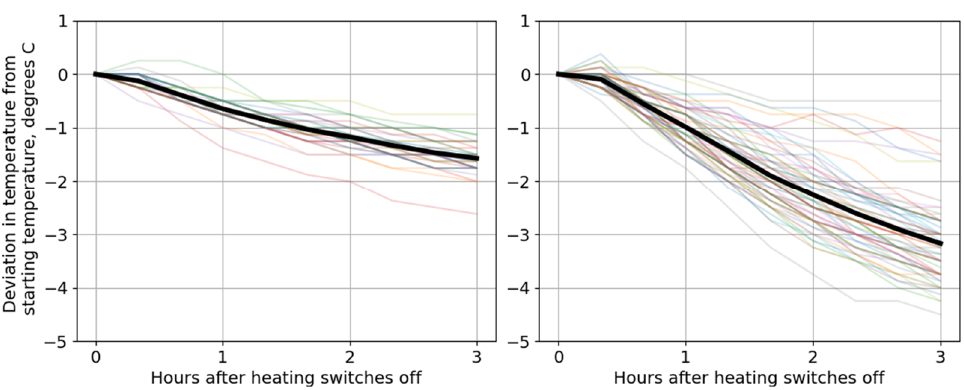
Figure 1. Internal temperature drops over 3 h for two homes in the LEEDR dataset. Left : house ID 05. Right : house ID 39. Coloured lines each represent one day; thick black lines represent the mean over all days. Data is aggregated from 1 min to 20 min to minimise the effect of sensor noise. Mean outdoor temperature for house ID 05: 4.4 °C and for house ID 39: 3.8 °C.